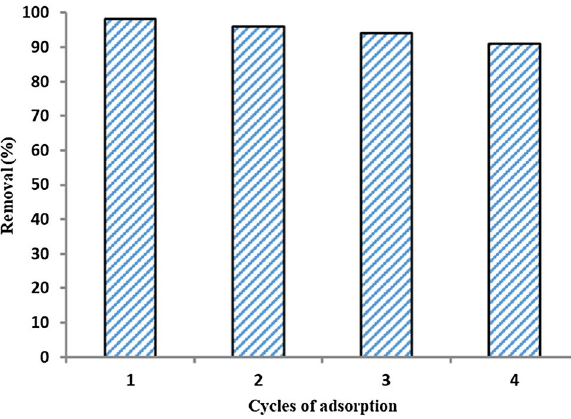
Figure 23. Recoverability and reusability of Fe 3 O 4 @Void@m.SiO 2 .